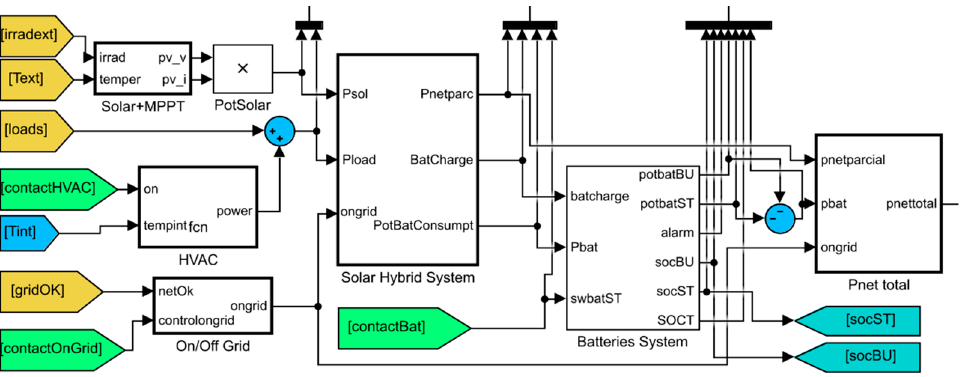
Figure 4. Electric system simulation.